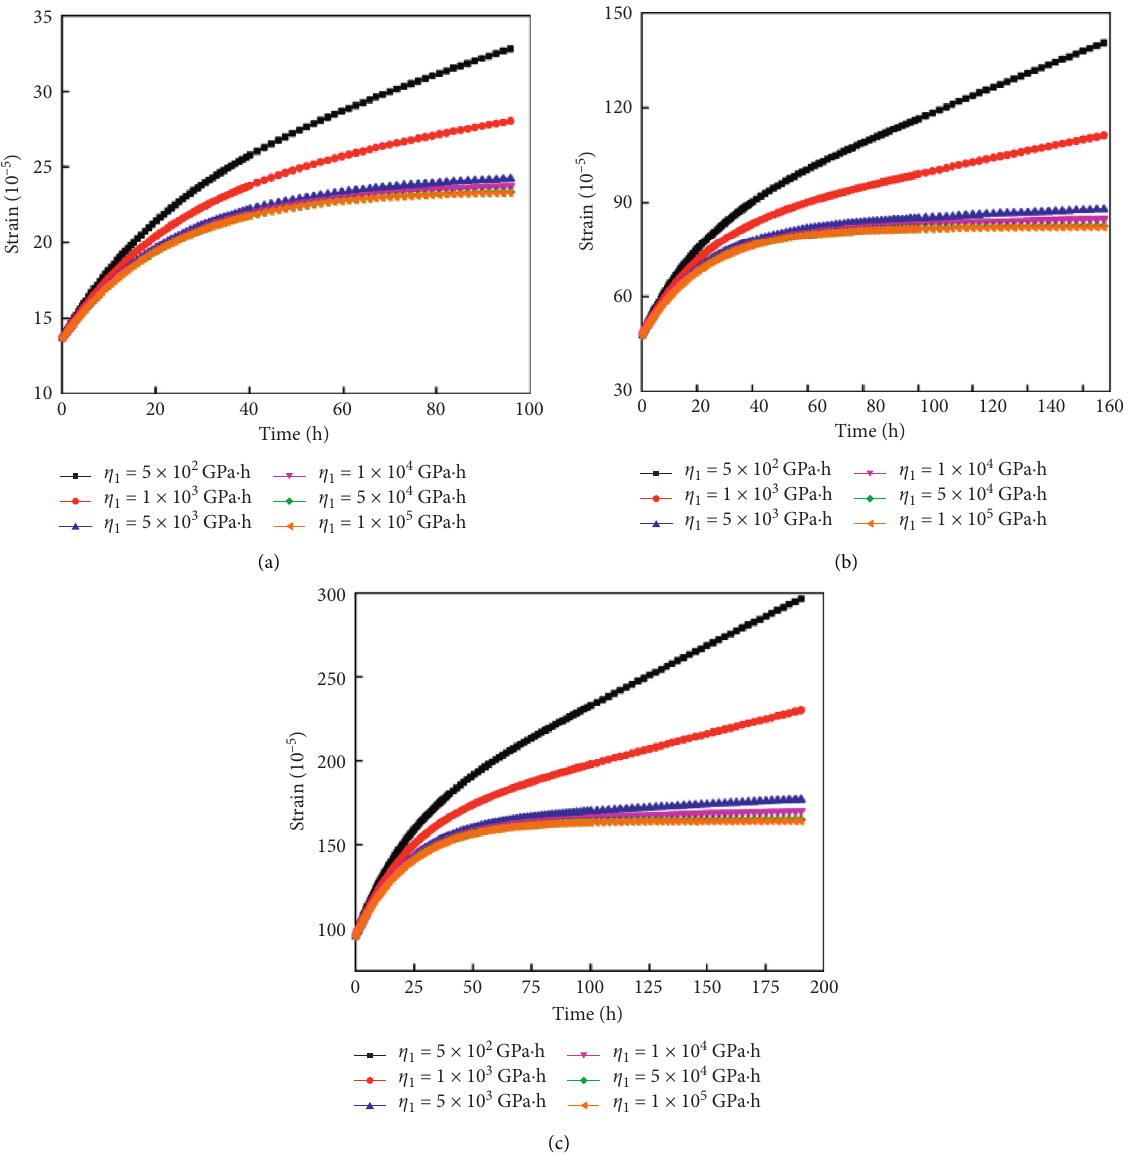
Figure 21: Effect of η 1 on the strain of tunnel anchor under loads of (a) 1.0 N m , (b) 3.5 N m , and (c) 7.0 N m